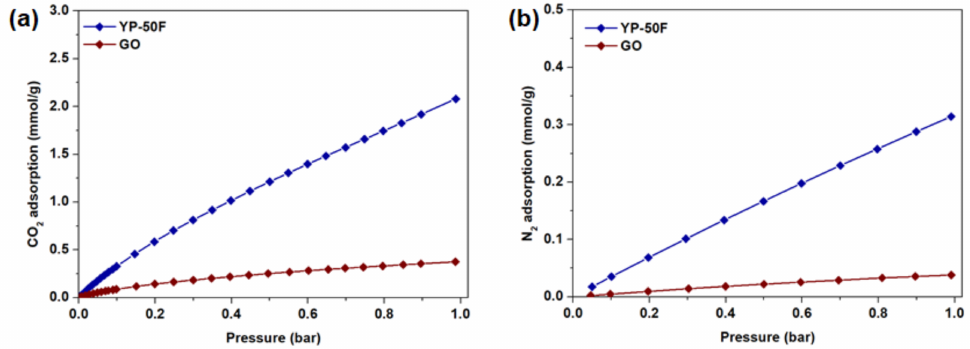
Figure 5. ( a ) CO 2 and ( b ) N 2 adsorption isotherms of GO and YP-50F at 35 ◦